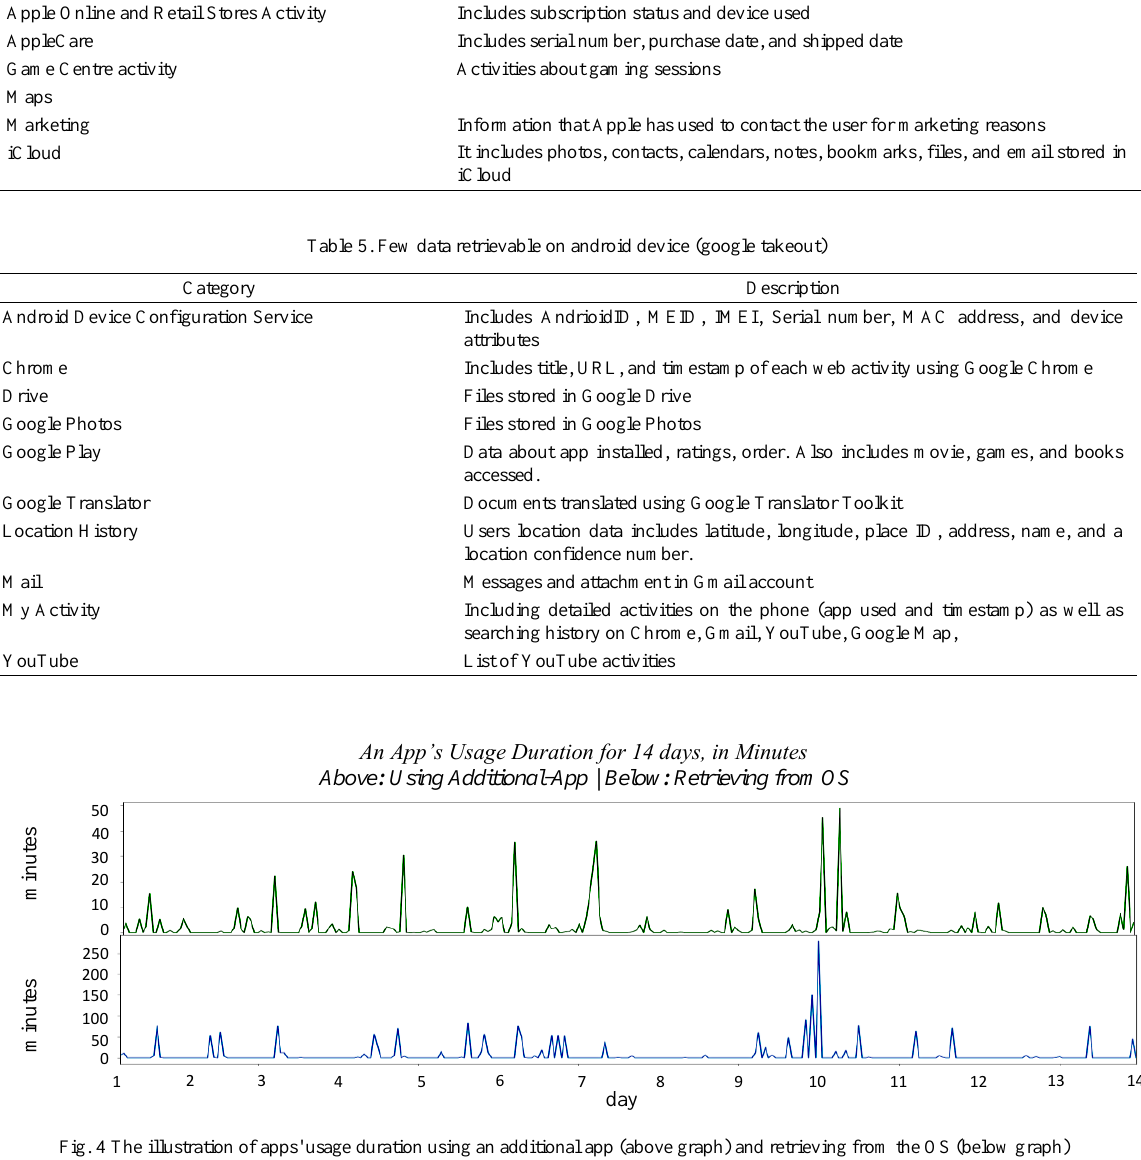
Fig. 4 The illustration of apps' usage duration using an additional app (above graph) and retrieving from the OS (below